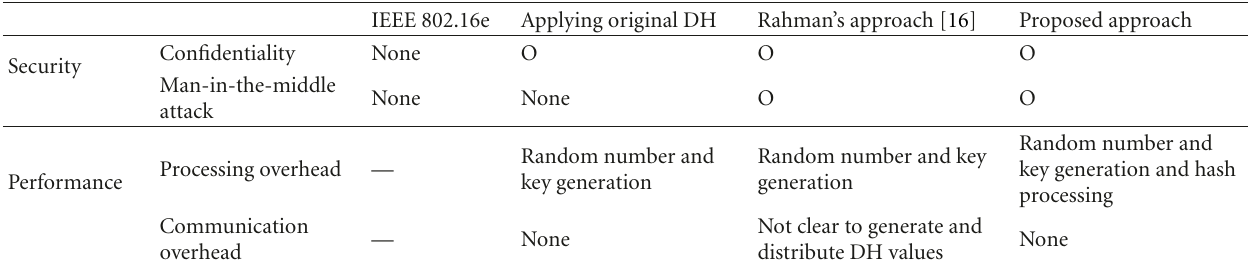
Table 1: Security and performance analysis in network entry security.